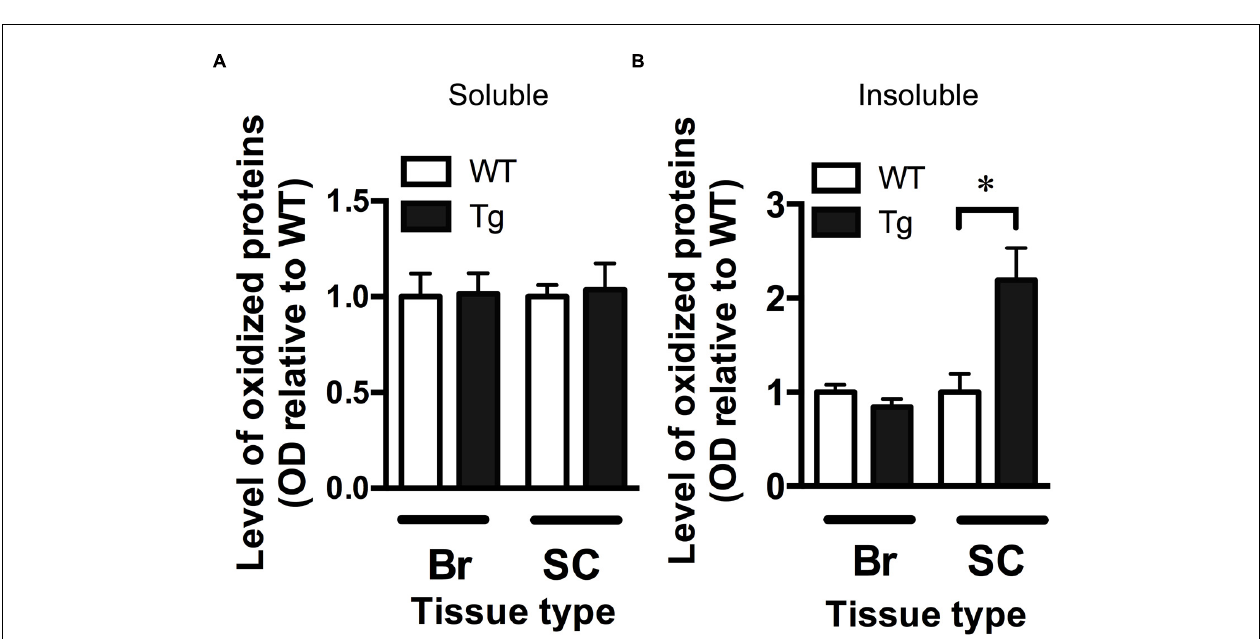
differences in bulk levels of Na, Mg, Al, P, K, Ca,Ti, Mn, Fe, Cu, and Zn in the brain between genotyptes ( n = 16 per genotype); however, (H) Mn, (J) Cu, and (K) Zn were significantly increased in the spinal cord ofTg mice compared toWT controls ( n = 7 per genotype). ** p < 0.01; * p < 0.5.